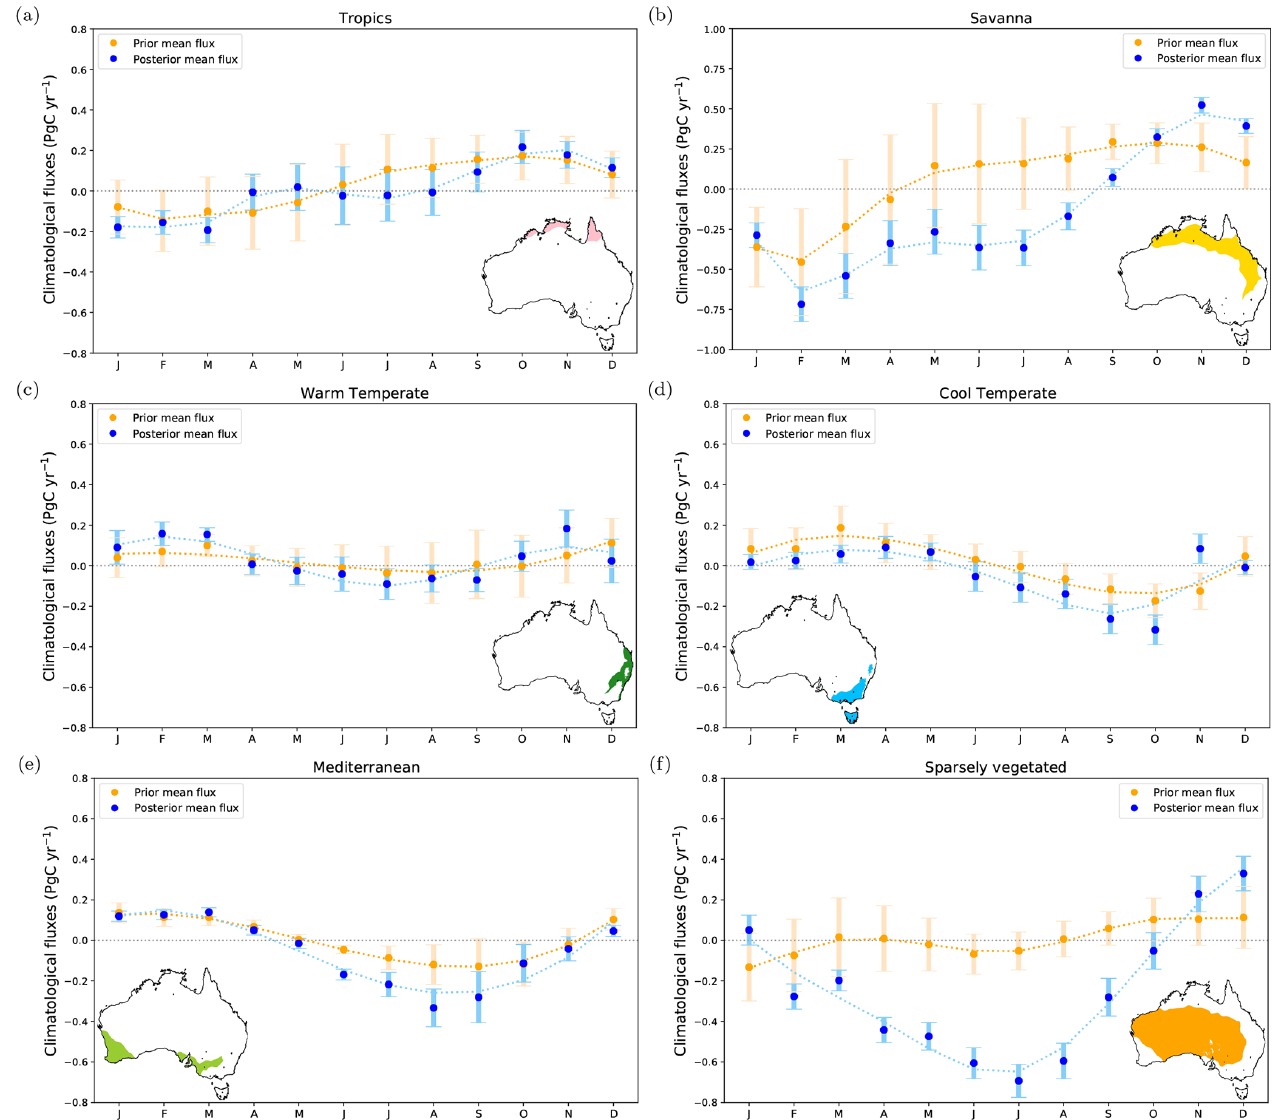
Figure 6. Climatological seasonal cycle of prior (orange points) and posterior (blue points) terrestrial carbon fluxes (2015–2019). The dashed orange and blue lines represent a smooth line for the prior and posterior fluxes